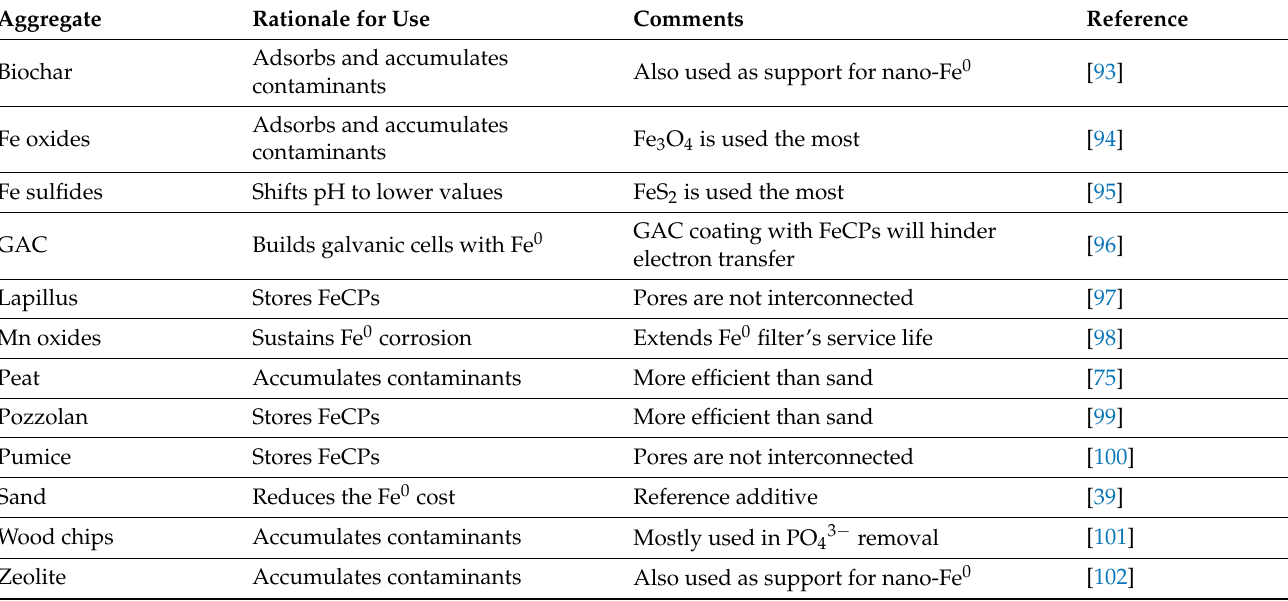
Table 2. Representative materials used as aggregates in Fe 0 /aggregate